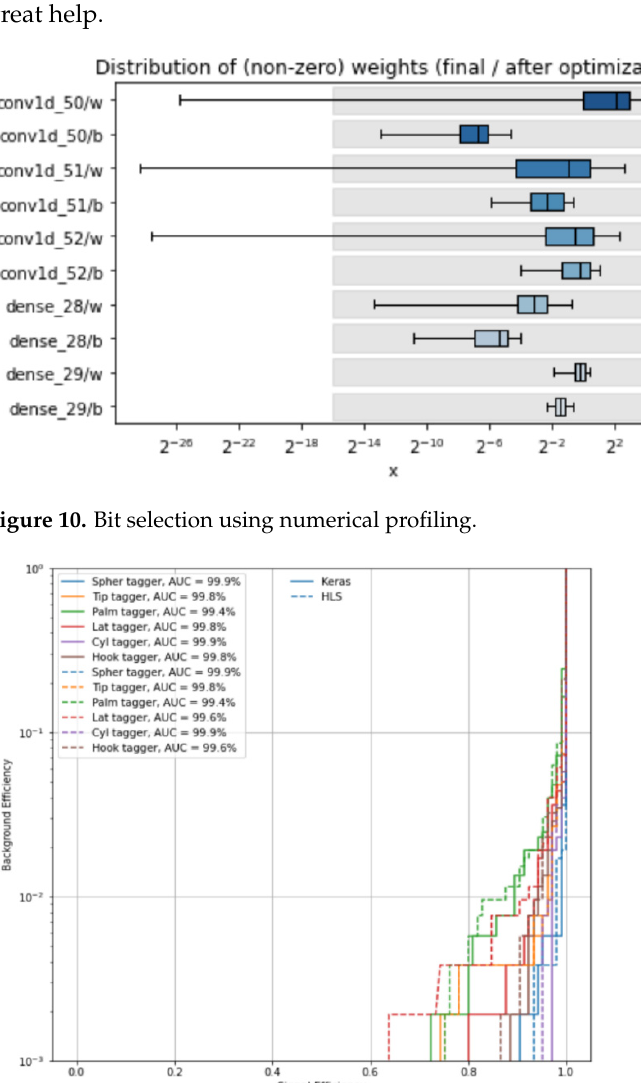
Figure 11. ROC curve for Keras and HLS (six categories).